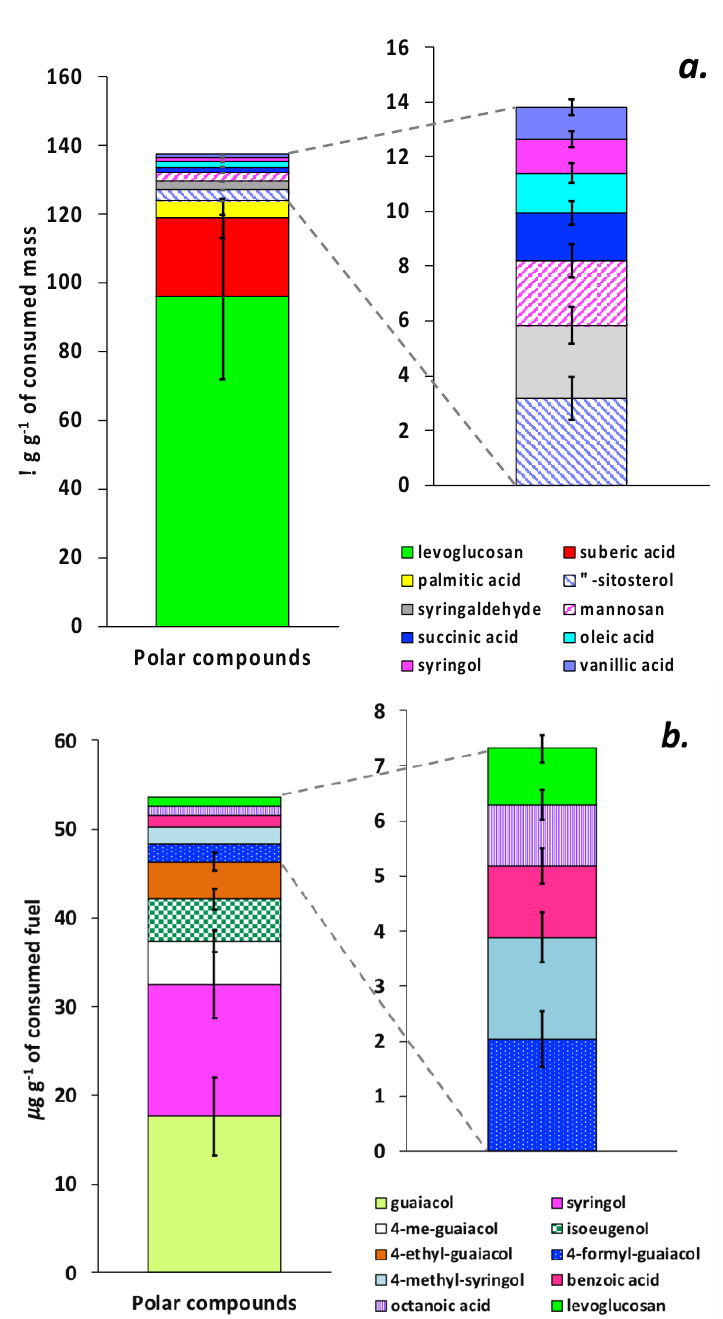
Figure 4. EFs (emission factors) for the ten most abundant polar organic compounds detected ( a ) in particle-phase and ( b ) semi-volatile gas-phase (XAD resin) combustion emissions from cheatgrass. The standard deviations represent analytical uncertainty.